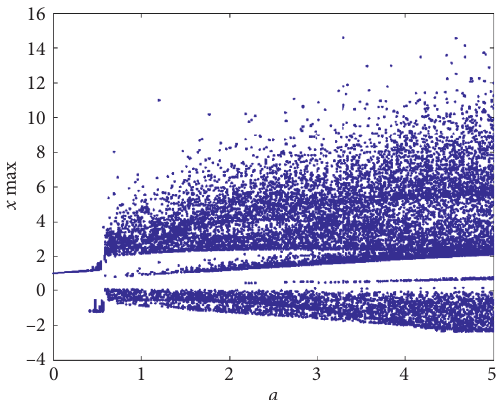
Figure 6: Bifurcation diagram versus the parameter a at order α � 0 . 95.